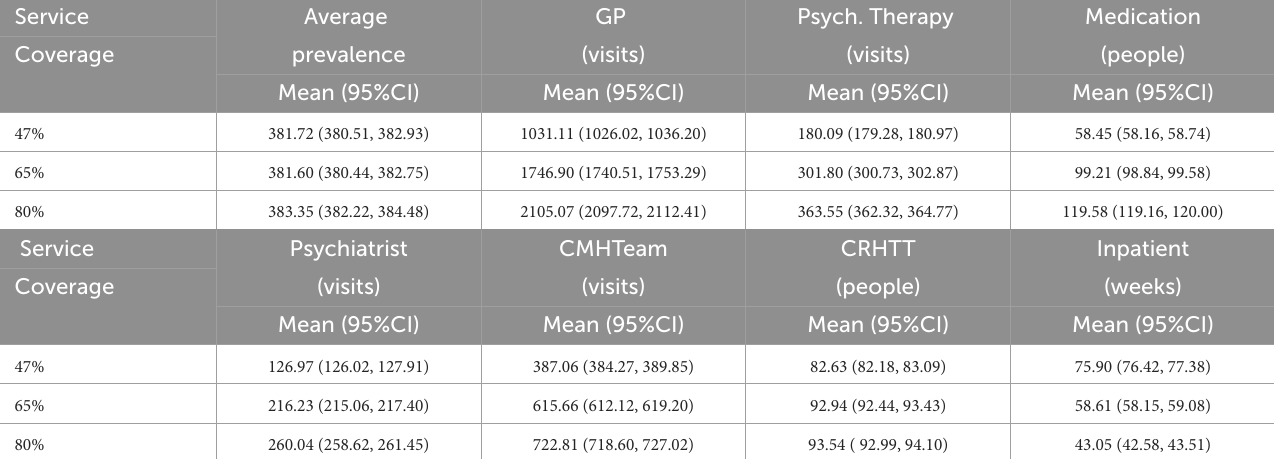
TABLE 4 Typical simulation results for mental health service use with different service